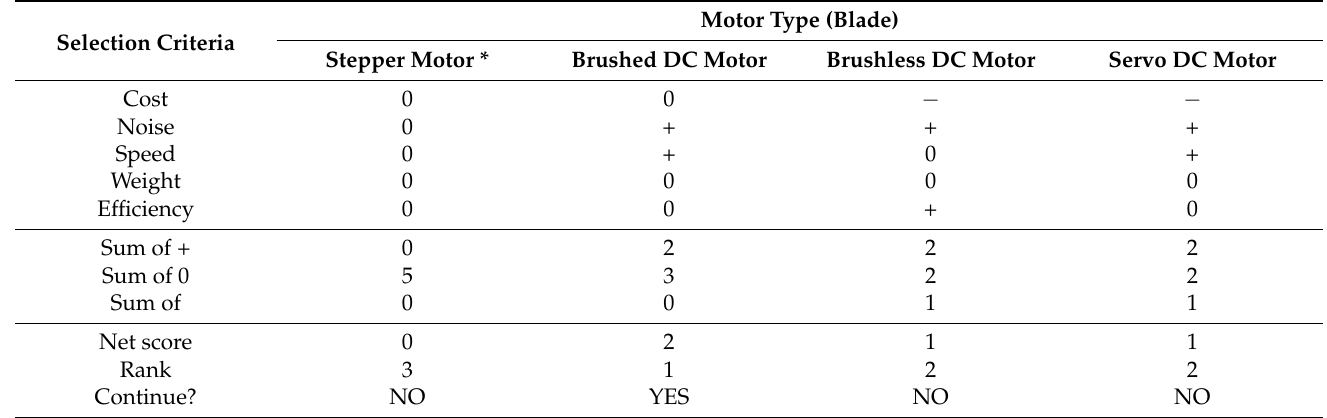
Table 7. Screening of blade motor types.